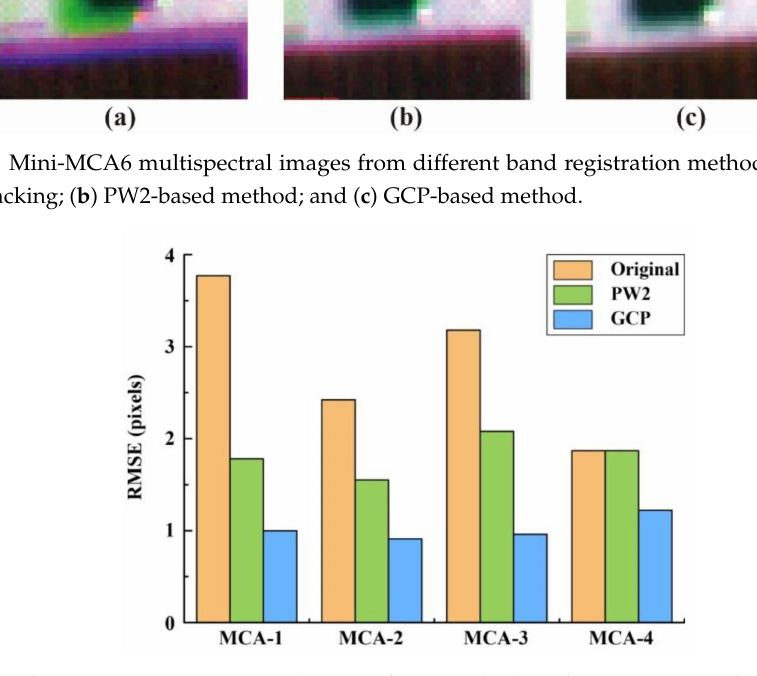
Figure 10. The root-mean-square error (RMSE) of mismatched pixels between each slave and the main channel for different band registration